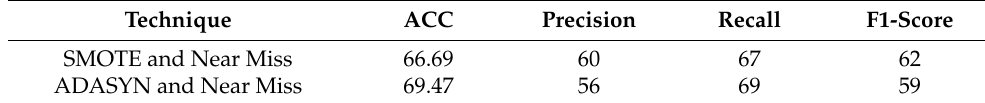
Table 12. Evaluation metrics for the Morris power dataset with hybrid sampling.